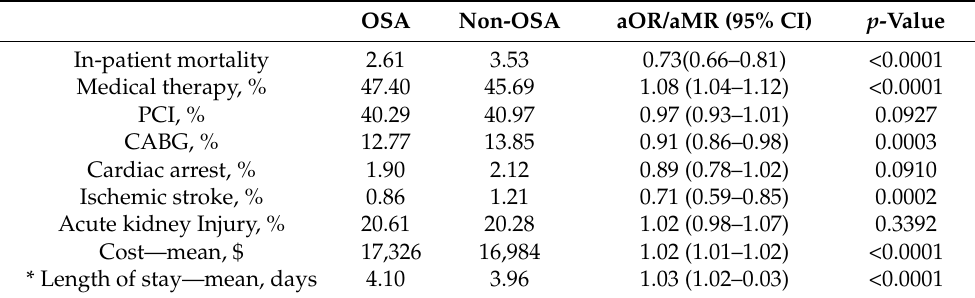
Table 2. Multivariate adjusted model predicting different clinical outcomes by patients with OSA in reference to patients with non-OSA.